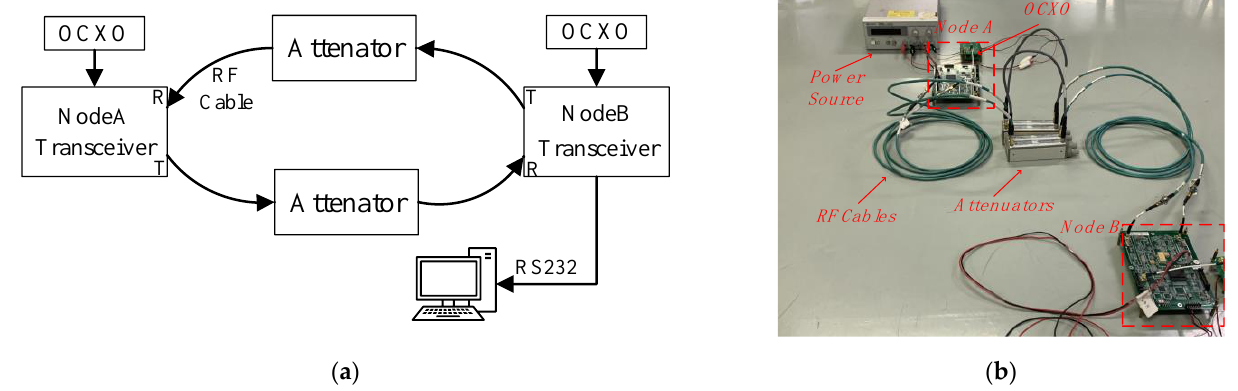
Figure 14. Test platform: ( a ) test platform concept; ( b ) test platform photo.